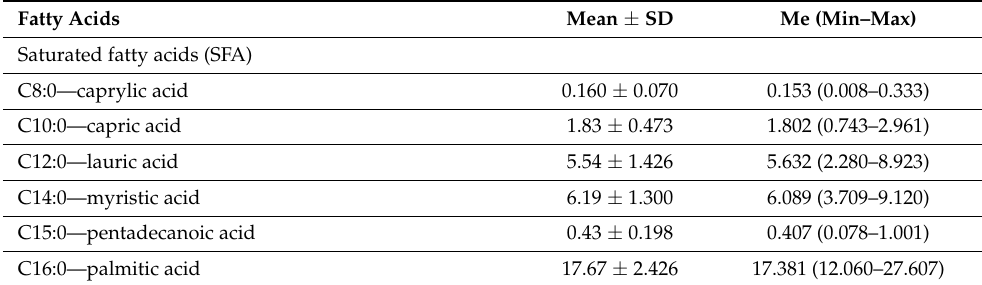
Table 3. Fatty acid content of breast milk (g/100 g of total